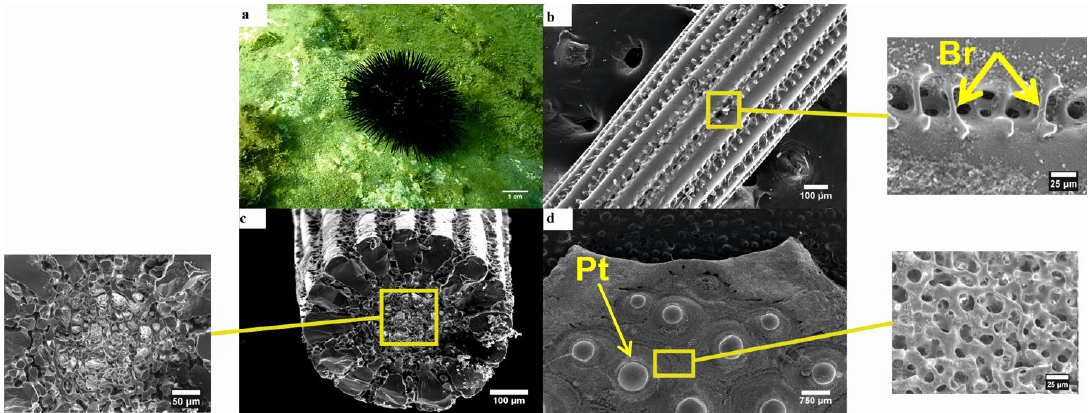
Figure 3. Black sea urchin Arbacia lixula . ( a ) General in situ view of the aboral side; ( b ) longitudinal section of the shaft of the spine (×100), with enlarged image showing bridges connecting two wedges (×650); ( c ) transverse section of the spine (×160), with enlarged image showing the porous zone (×350); ( d ) section of the test from the peristomal region (×16), with enlarged image showing the stereom of the outer surface of the plate (×600). Br—bridges, Pt—primary tubercles.